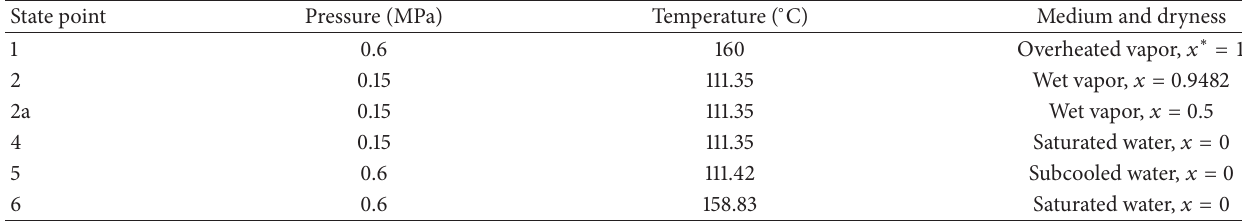
Table 1: Parameters of the second fluid at the inlet/outlet of each part.